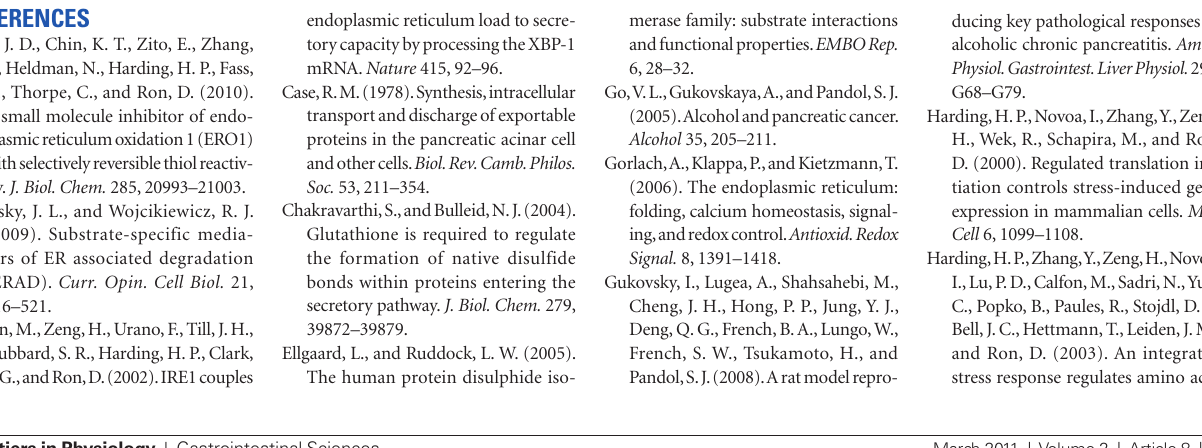
FigURe 4 | Oxidative folding in the eR. This figure illustrates the ER oxido-reductases involved in oxidative folding of nascent proteins in the ER. The oxido-reductases PDI and ERO1 are coupled and mediate the disulfide bridge formation and protein folding of proteins such as digestive enzymes